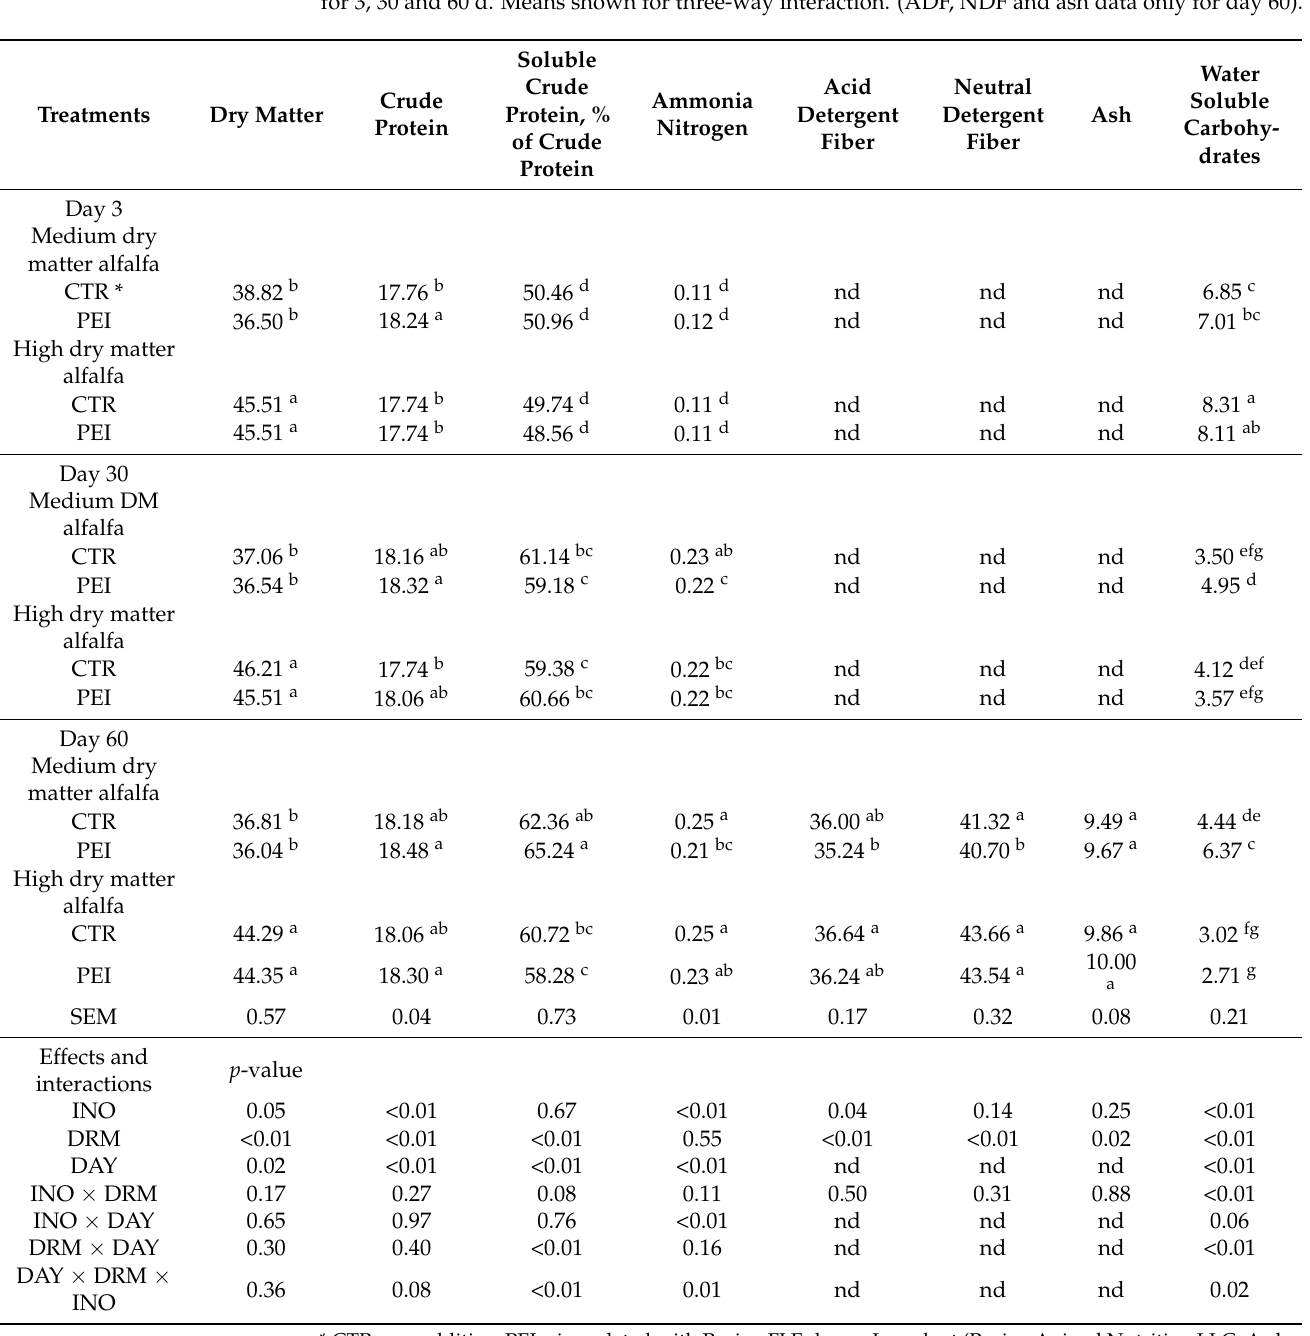
Table 3. The DM and chemical analysis (% DM basis unless stated otherwise) of alfalfa silage ensiled for 3, 30 and 60 d. Means shown for three-way interaction. (ADF, NDF and ash data only for day